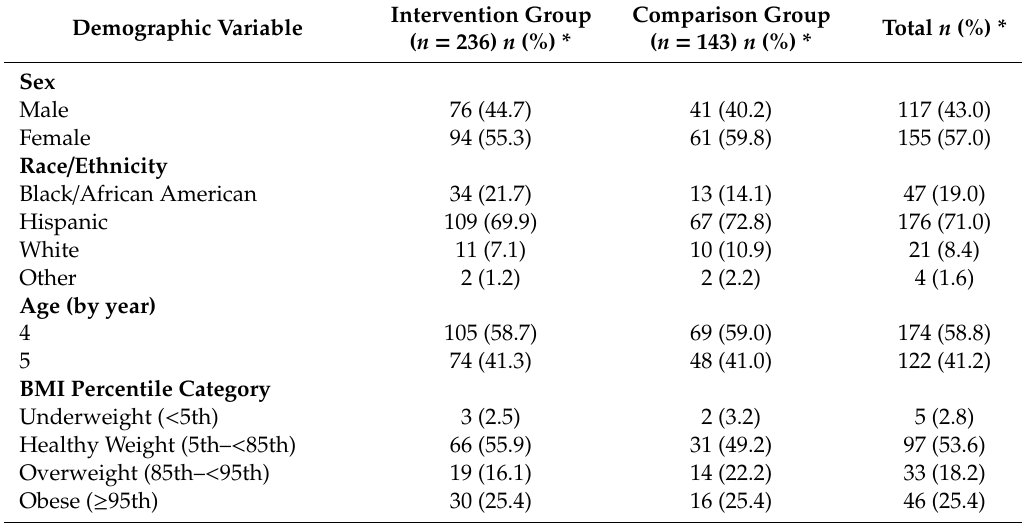
Table 1. Population Characteristics, COMPARISON Study, All 4 Kids © Program ( n = 379).